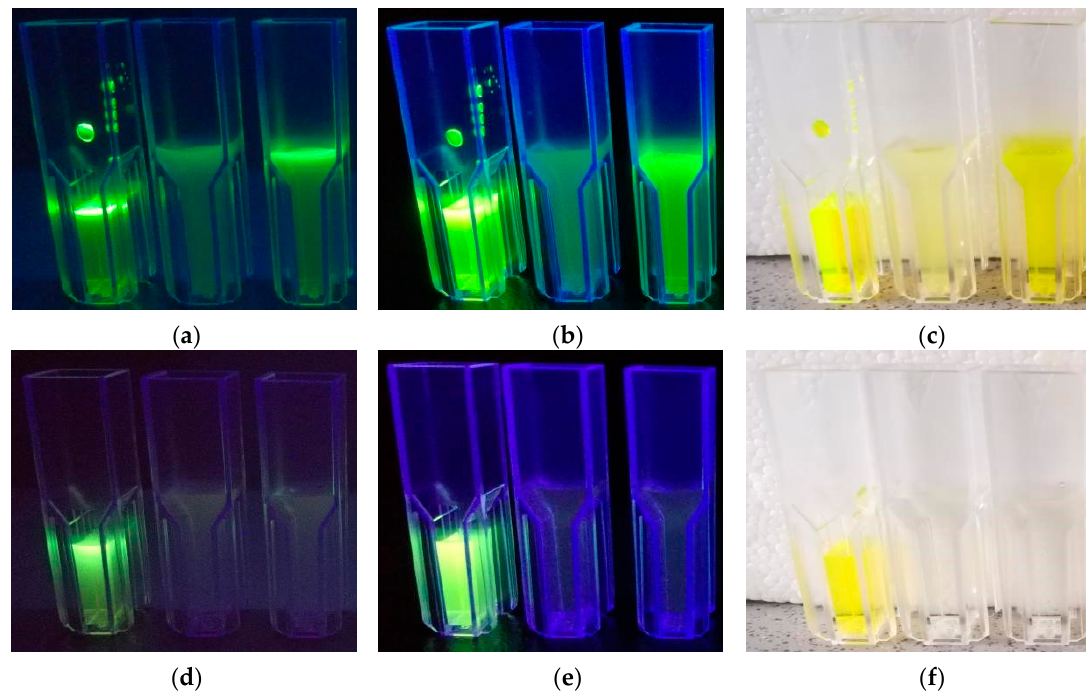
Figure 2. Color changes of solutions of MOAF ( a – c ) and DIAF ( d – f ) with L-Cysteine under UV-light at 254 nm ( a , d ), 365 nm ( b , e ) and visible light ( c , f ). The left cuvette shows sole MOAF (1 mM)/DIAF (0.5 mM), respectively, the middle cuvette MOAF/DIAF mixed with 5 mM L-Cysteine and the right cuvette MOAF/DIAF commingled with 0.5 mM L-Cysteine hydrochloride monohydrate. The usage of DIAF for Cys detection delivered faster results for the color changes and fluorescence quenching.